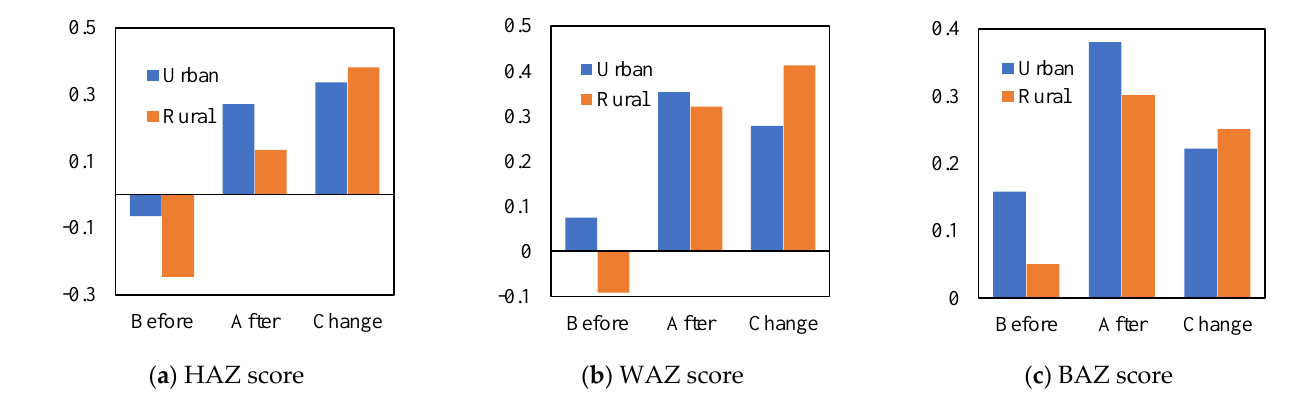
Figure 4. Changes in child health after the HAGC policy.